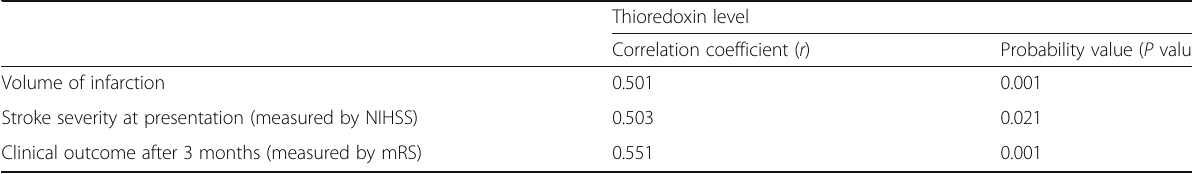
Table 5 Correlation between thioredoxin level, radiological, and clinical parameters